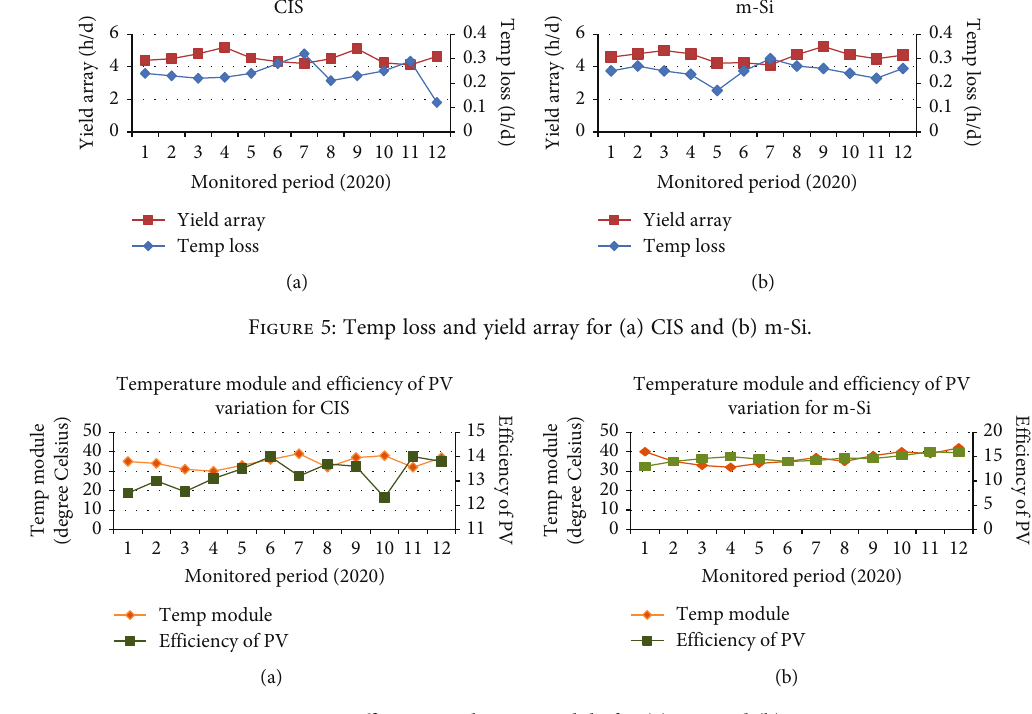
Figure 6: PV e ffi ciency and temp module for (a) CIS and (b) m-Si. Table 9: System loss, fi nal yield, system e ffi ciency, and capture losses monthly variation for PV